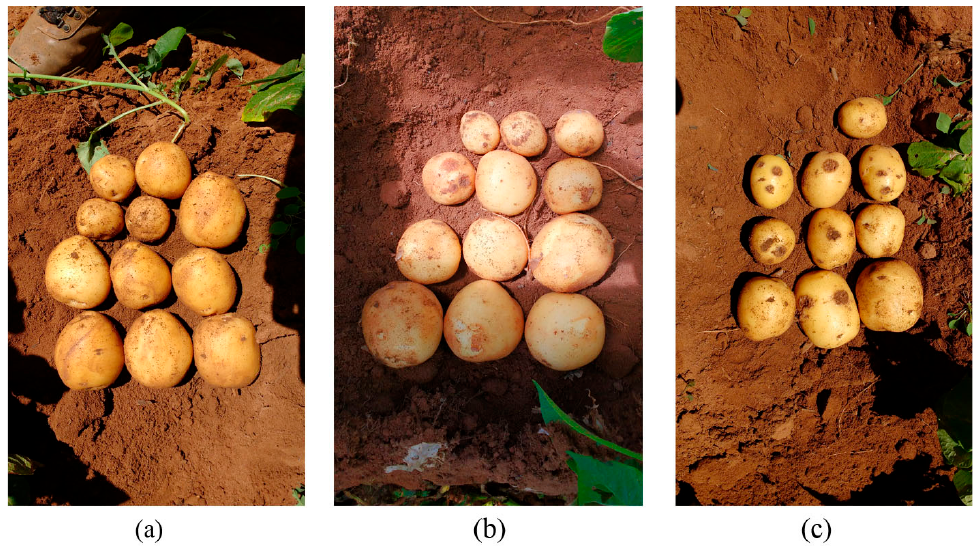
Figure 2. Tuber sample showing effects of microorganisms on potato common scab. Tubers obtained after treatment with ( a ) T. longibrachiatum (TL), ( b ) T. asperellum (TA), and ( c ) control (without